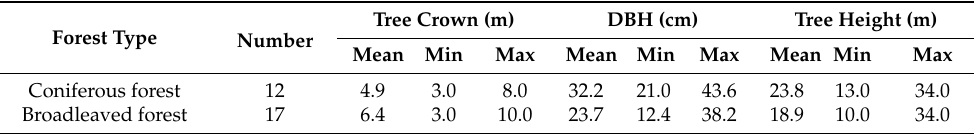
Table 2. Structural characteristics of coniferous and broadleaved forest based on field forest inventory